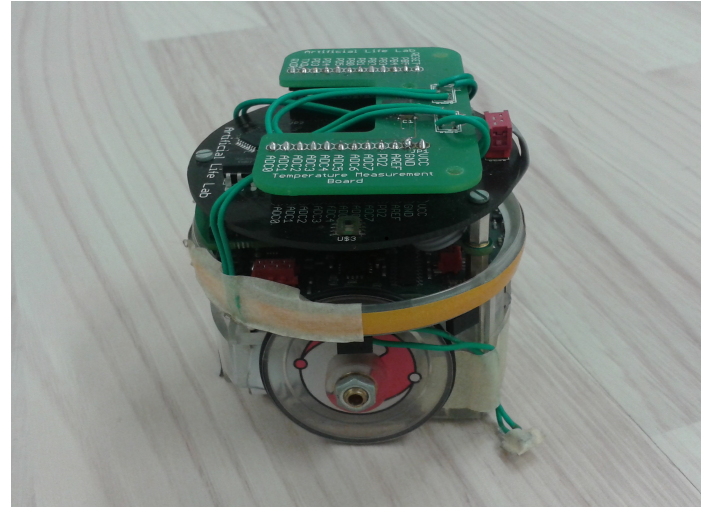
Figure 1: e-puck with the extension board (on top) and a temperature sensor (at the left side slightly above